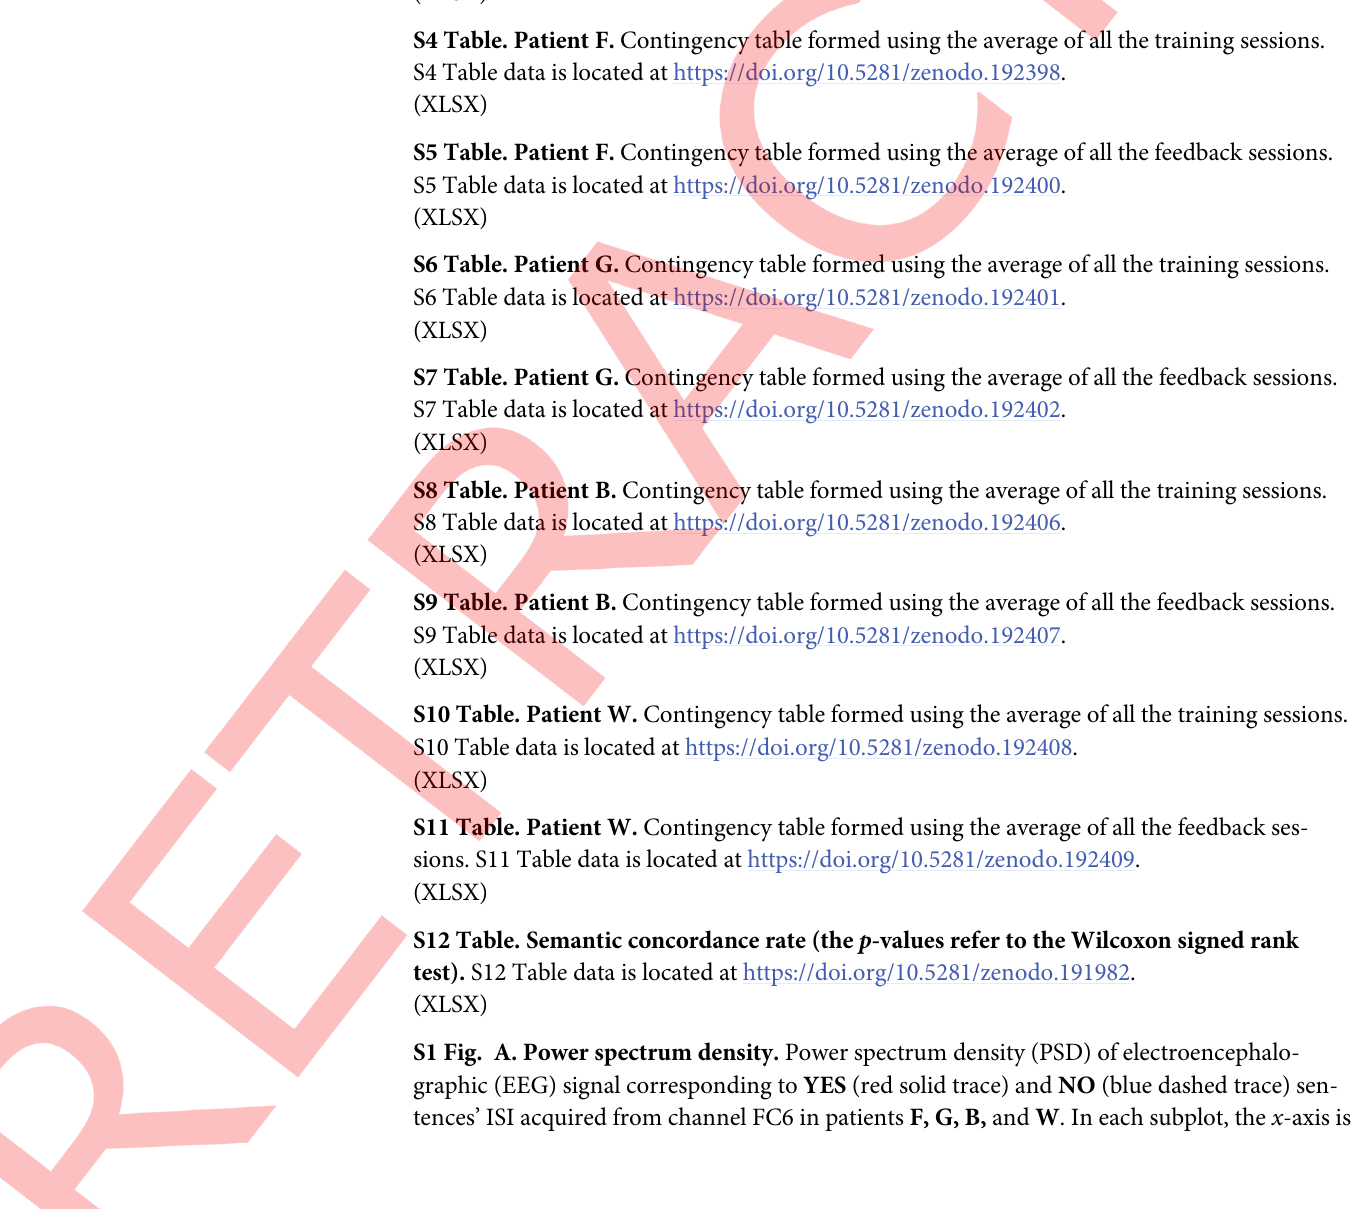
S1 Fig. A. Power spectrum density. Power spectrum density (PSD) of electroencephalo- graphic (EEG) signal corresponding to YES (red solid trace) and NO (blue dashed trace) sen- tences’ ISI acquired from channel FC6 in patients F, G, B, and W . In each subplot, the x -axis